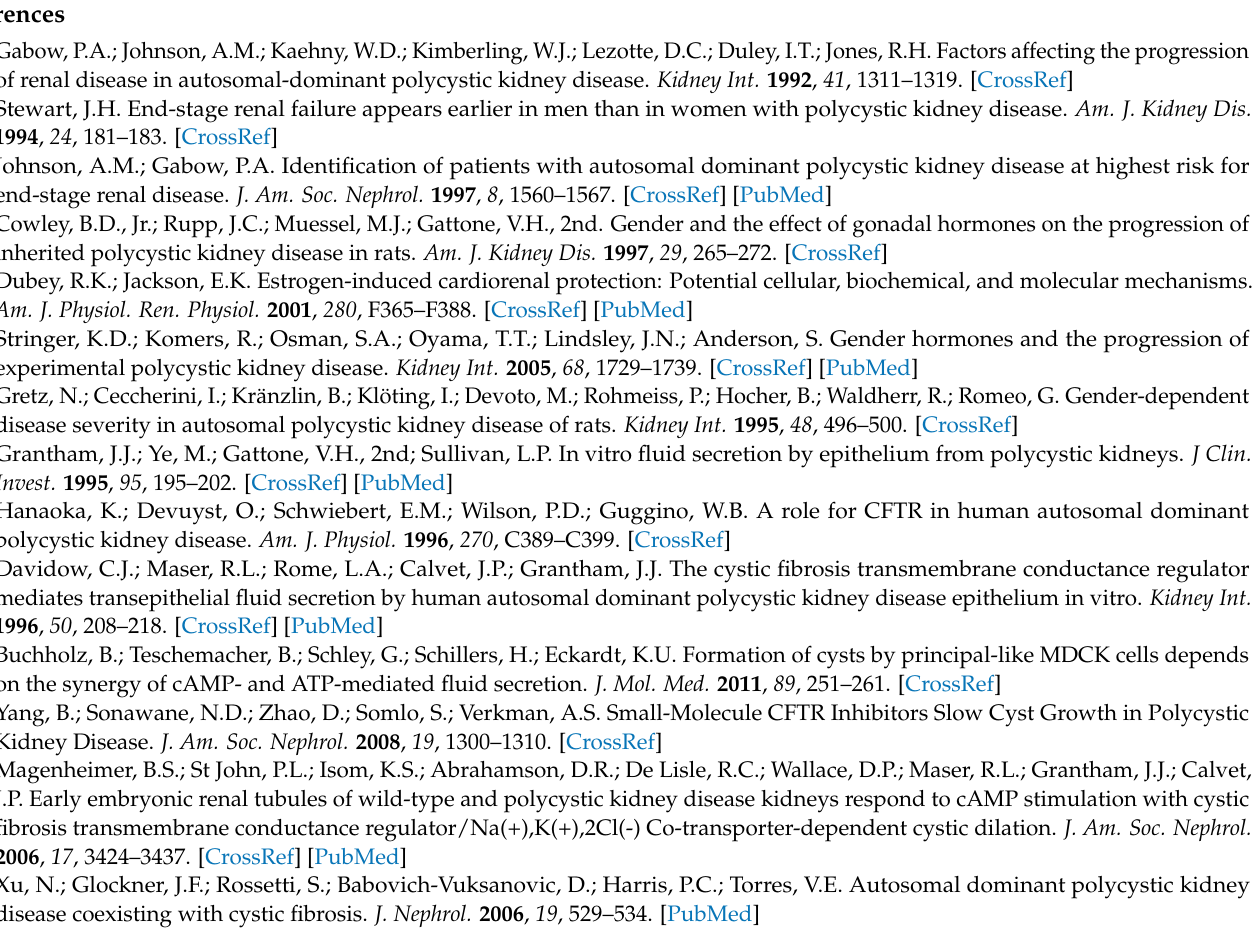
epithelial cells. Supplementary Figure S2. YFP-quenching to assess anion permeability. Supplemen- tary Figure S3. Ion currents in M1 mouse collecting duct cells. Supplementary Figure S4. Basal and ATP-induced intracellular Ca 2+ in primary renal epithelial cells. Supplementary Figure S5. CPA-induced store release in male and female primary renal epithelial